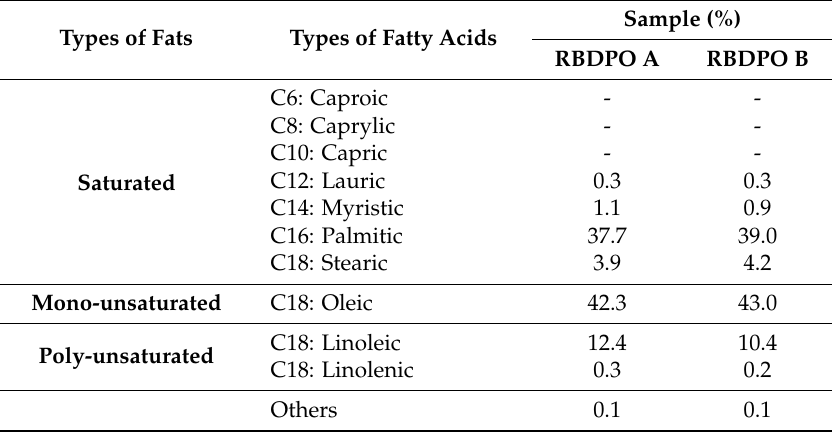
Table 1. Fatty acid compositions of all